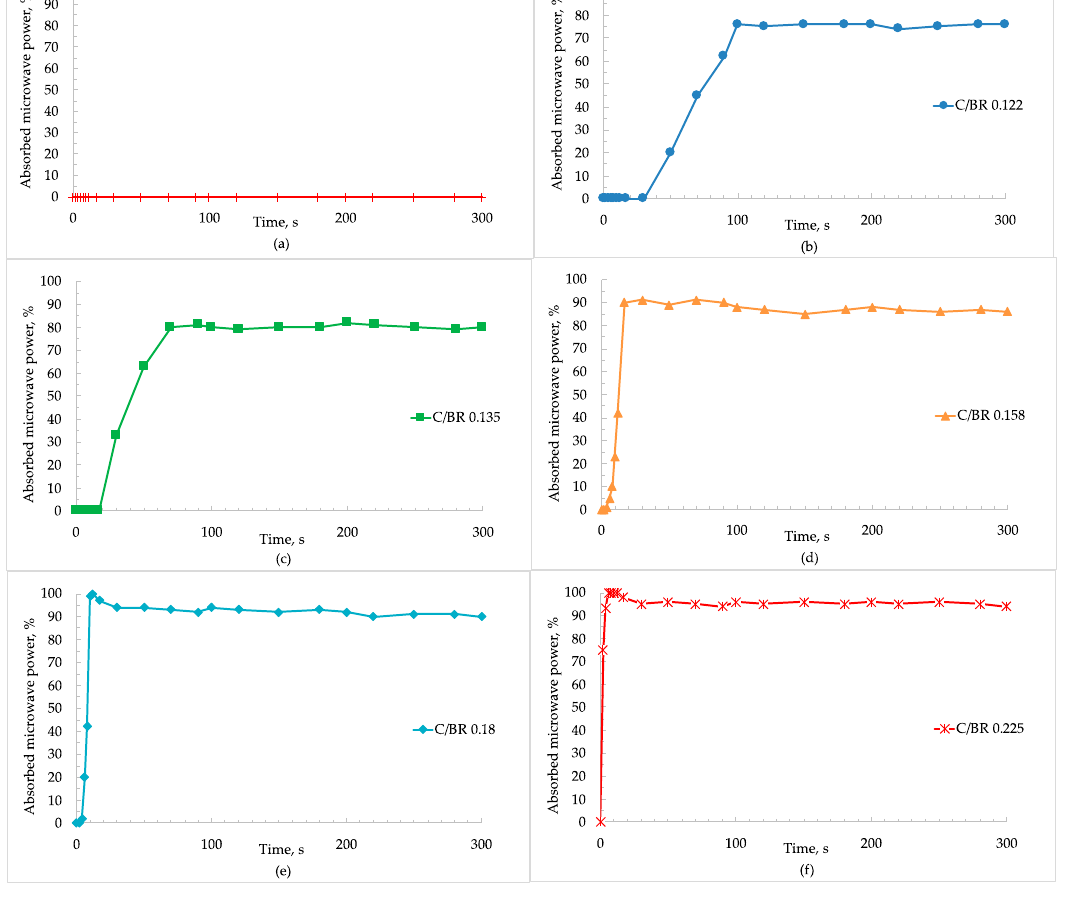
Figure 10. Percentage of absorbed microwave power from BR without the C addition, ( a ) and varying C / BR ratios ranging between 0.122 and 0.225 at 0.6 kW (30%), 1 L / min N 2 flow constant for 300 s, ( b ) Percentage of absorbed microwave power from C / BR 0.122, ( c ) Percentage of absorbed microwave power from C / BR 0.135, ( d ) Percentage of absorbed microwave power from C / BR 0.158, ( e ) Percentage of absorbed microwave power from C / BR 0.180, ( f ) Percentage of absorbed microwave power from C / BR 0.225)